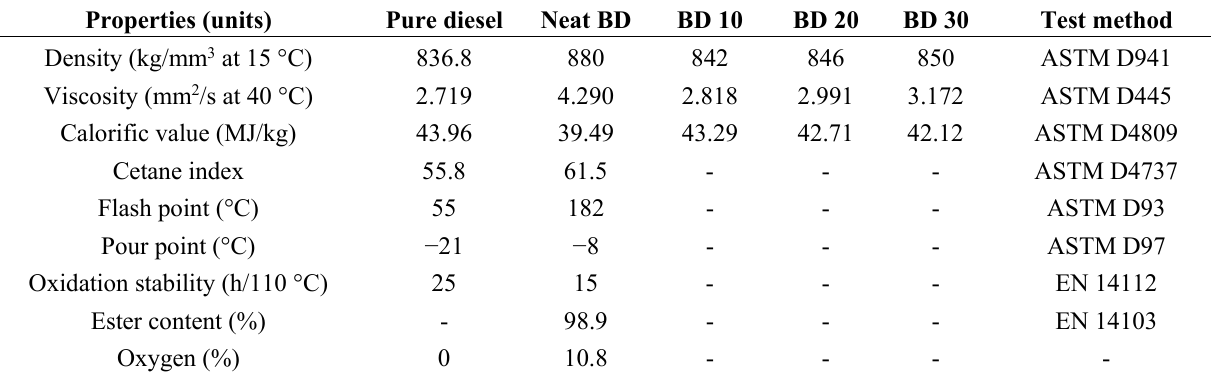
Table 1. Properties of pure diesel, neat biodiesel and biodiesel (BD) blends.